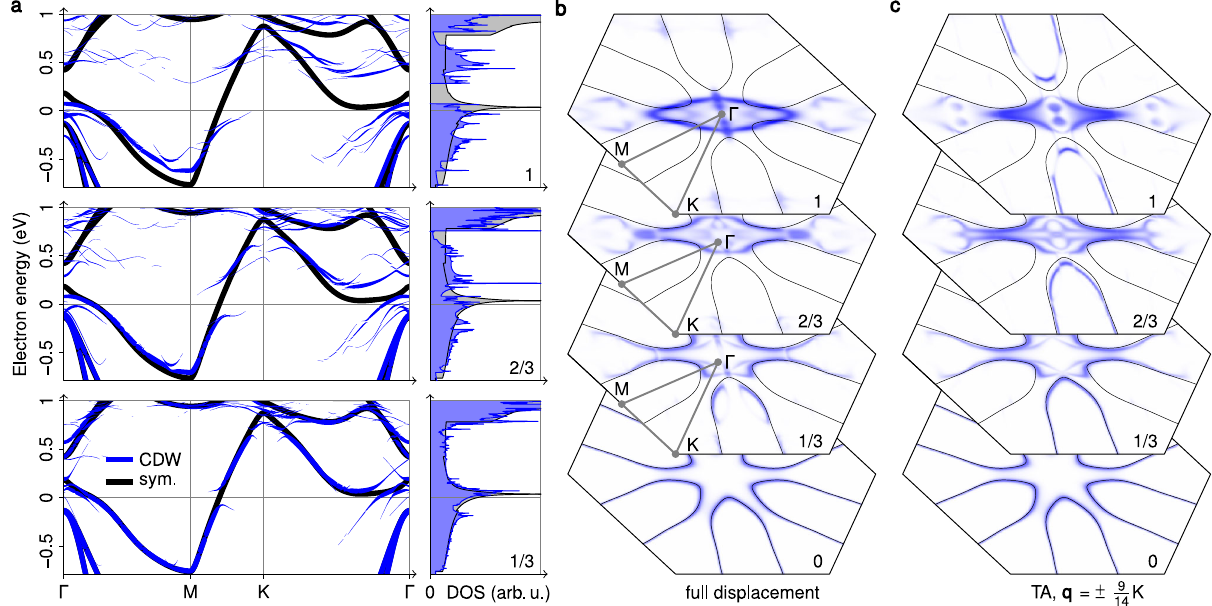
ffiffiffi p 3 R30 (cid:4) CDW is shown in black and blue, ffiffiffi p 3 R30 (cid:4) CDW are shown in Supplementary Fig. 3.